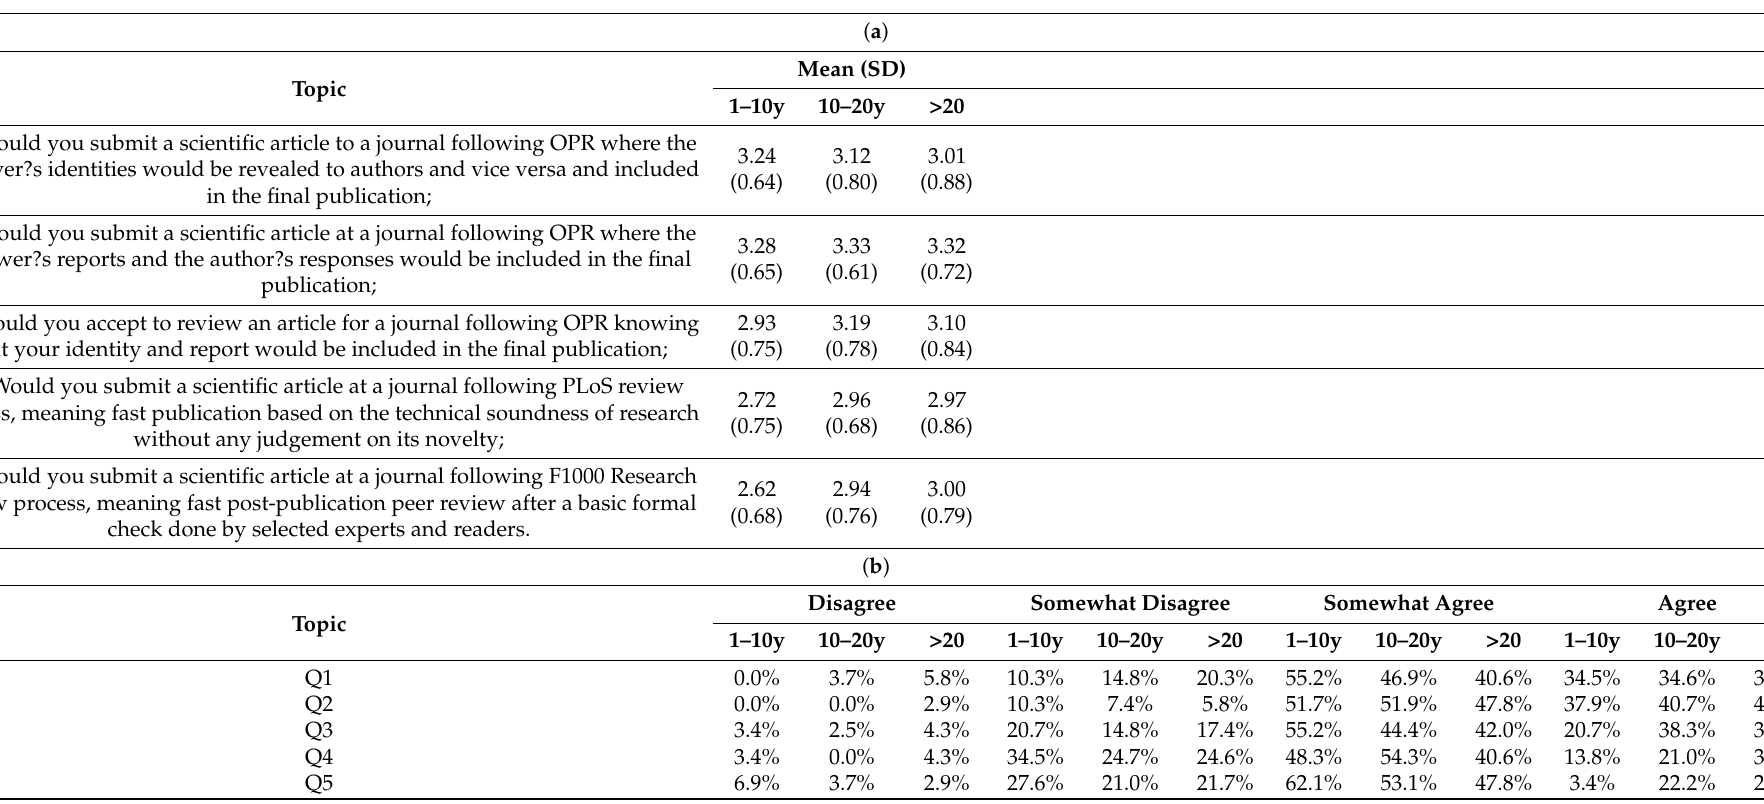
Table 8. ( a ) Define your position regarding Open Peer Review potentials-Mean and Standard Deviation per topic (Part 3, Q1 to Q5, years of experience: 1–10y, 10–20y, >20y); ( b ) Define your position regarding Open Peer Review potentials-Percentages per topic (Part 3, Q1 to Q5, years of experience: 1–10y, 10–20y,